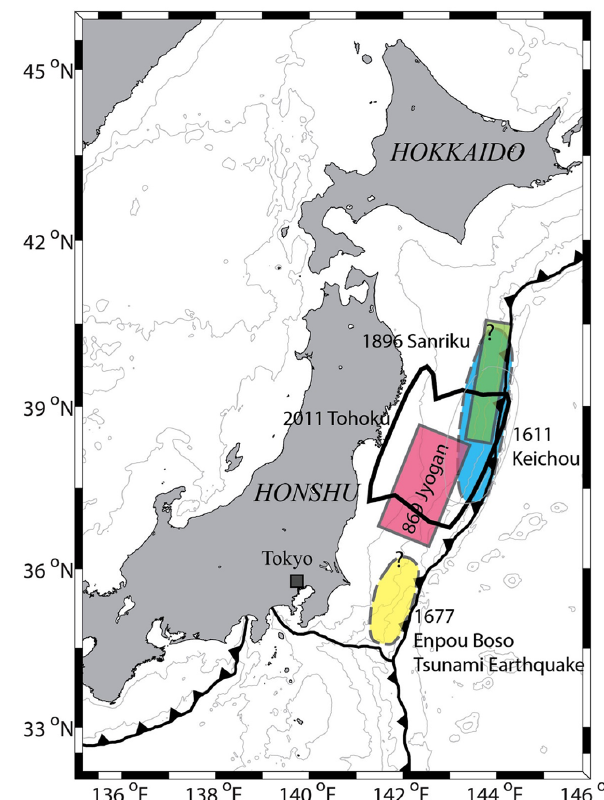
Figure 1. Map of the Japan Trench region showing historical tsunamigenic earthquake rupture areas (Hatori, 2003; Tanioka and Gusman, 2012; Sawai et al.,